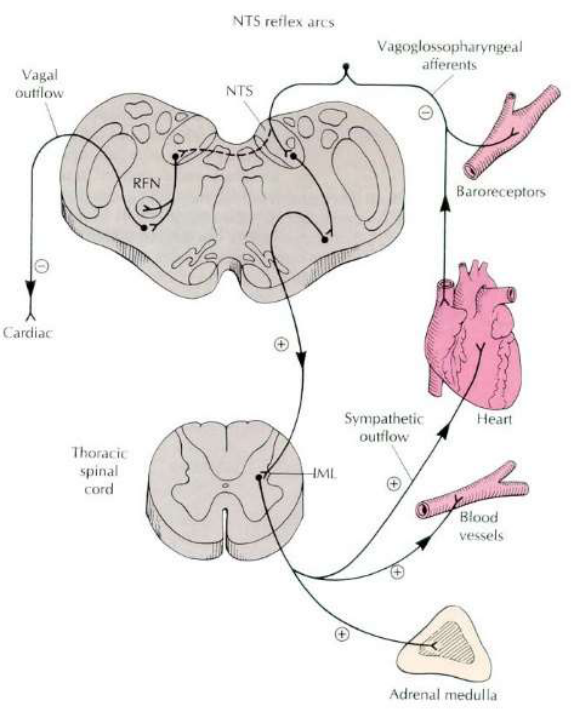
Figure 1. NTS reflex arcs.